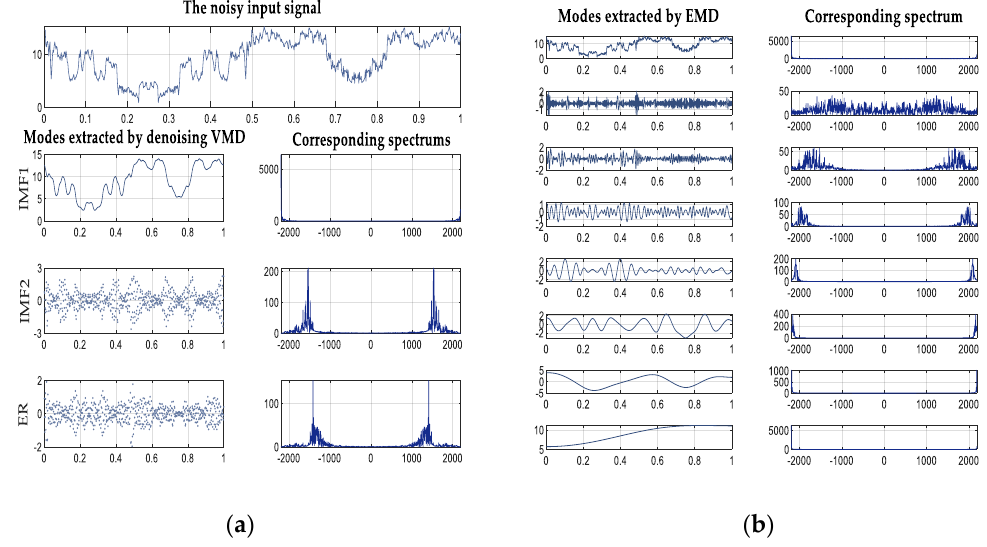
Figure 8. The decomposed results of wind speed. ( a ) The decomposed results of wind speed by VMD; ( b ) the decomposed results of wind speed by EMD.